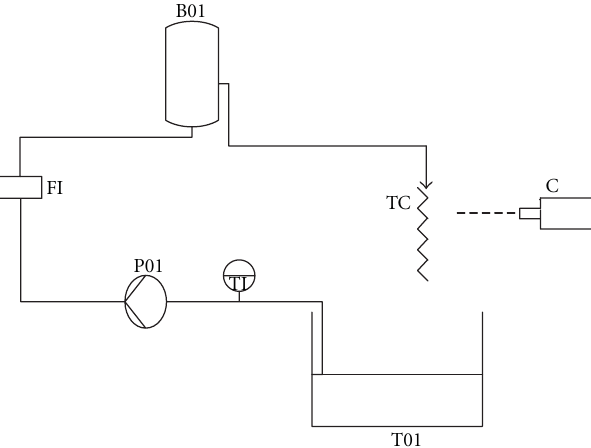
Figure 6: Experimental setup used in wetting studies. Sample picture from Water-Glycerol study. P01: pump; B01: bu ff er tank; TC: test cell; C: camera; FI: flow indicator; TI: thermocouple; T01: solution